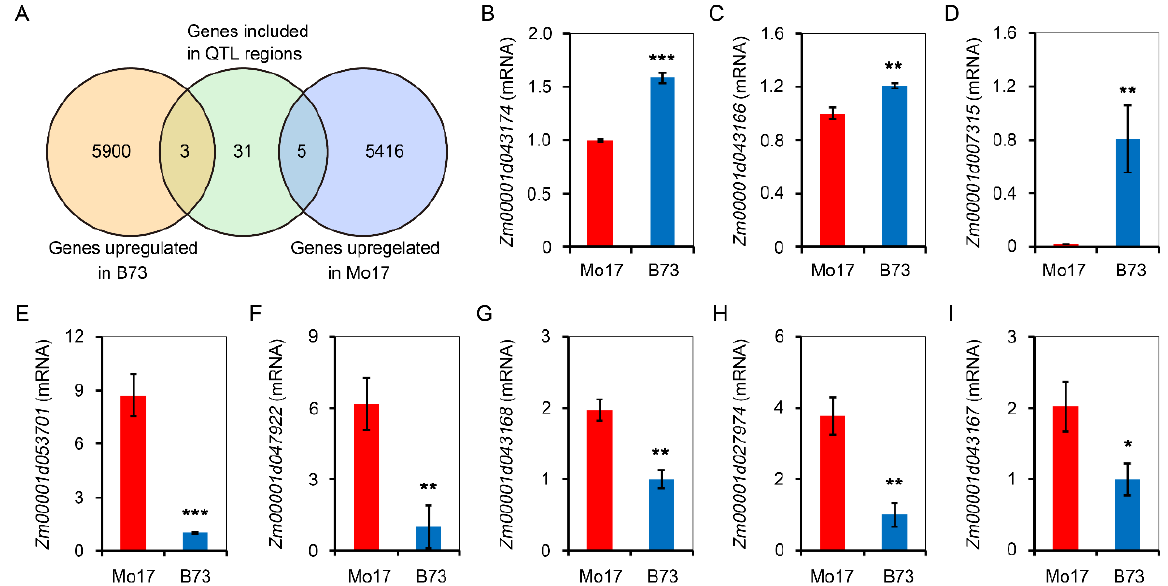
Figure 5. Comparison of QTL located genes and the genes upregulated in B73 or Mo17 seeds/seedling under low temperature. ( A ) Venn diagram showing overlapping genes between included by QTL region and upregulated in B73 or Mo17 seed/seedling. The seed/seedling used for RNA-Seq were extracted from B73 or Mo17 which was treated at 10 °C for 10 d. There are three replicates for each treatment. ( B – I ) Comparison of mRNA accumulation of Zm00001d043174 , Zm00001d043166 , Zm00001d007315 , Zm00001d053701 , Zm00001d047922 , Zm00001d043168 , Zm00001d027974 , and Zm00001d043167 in B73 or Mo17 seeds/seedling which was treated at 10 °C for 10 d. Values are means ± SE (n = 3). Asterisk represents significant difference. * p < 0.05, ** p < 0.01, *** p < 0.001 (Student’s t test).